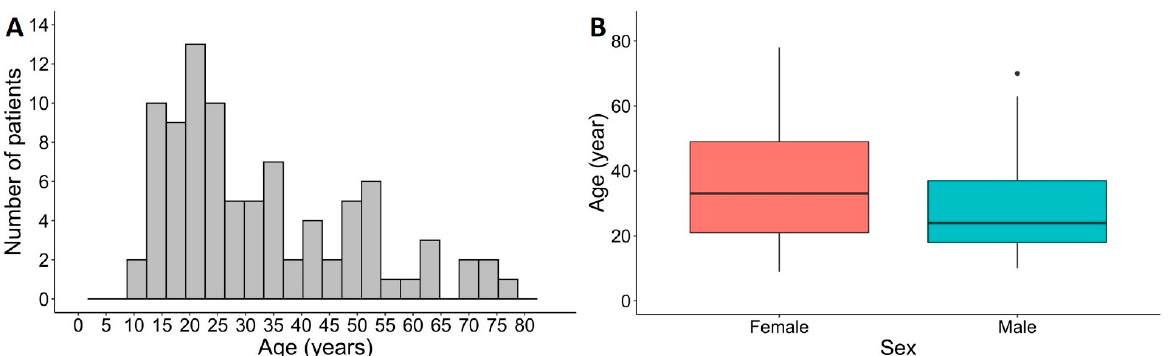
Figure 2. Demographic characteristics of immunocompetent patients with common warts included in the study. ( A ) Age distribution of patients ( n = 90). ( B ) Age distribution of patients by sex. The median age of females ( n = 47) was 33 years, and the median age of males ( n = 43) was 24 years. At study entry, a single common wart was obtained from 57/90 patients (63.3%), two warts from 28/90 patients (31.1%), and three different warts from 5/90 patients (5.6%; Ta- ble S1). The median duration of the presence of common warts was 12 months, ranging from 1 to 120 months. Of the 128 common warts sampled, 96/128 (75.0%) warts were